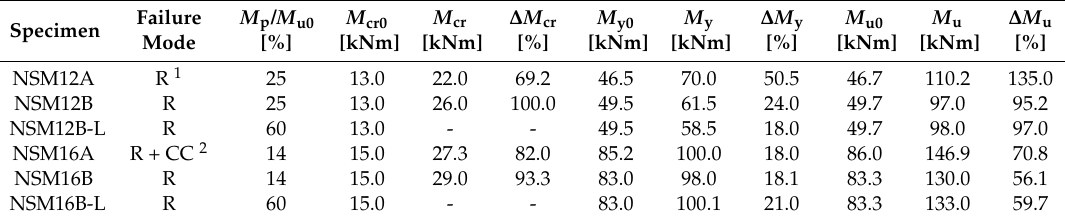
Table 3. Summary of test results.